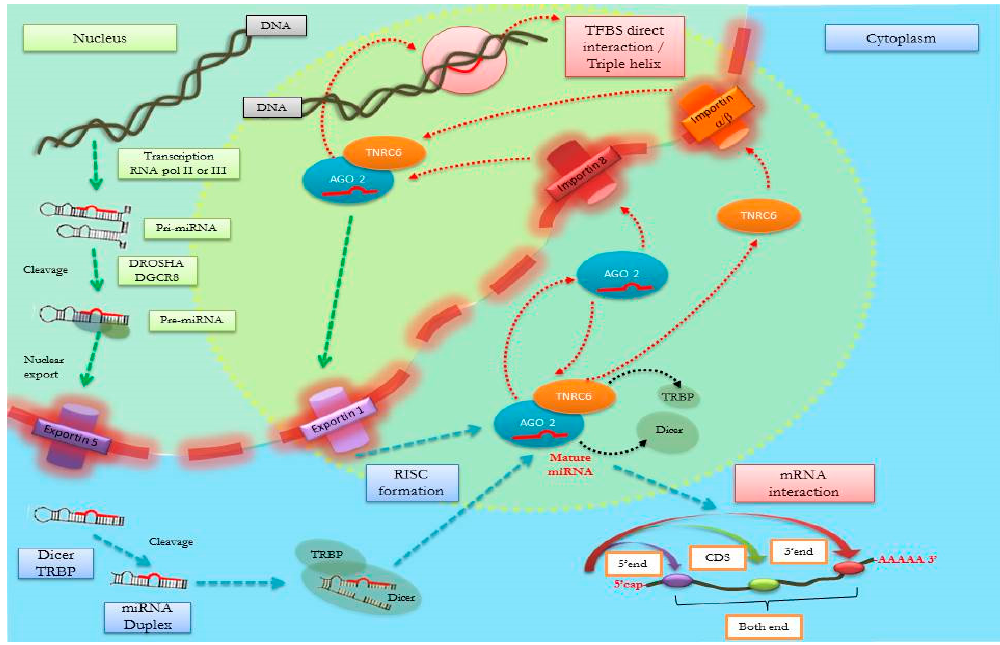
Figure 4. Several steps of microRNA (miRNA) biogenesis and nucleus–cytoplasm transport. Mature miRNAs derive from longer double-stranded primary transcripts (pri-miRNA), which are recognized and processed in the nucleus by the Drosha protein/DGCR8 microprocessor complex subunit (DGCR8) complex into shorter precursors folded in a hairpin loop structure (pre-miRNA). Pre-miRNAs are then exported to the cytoplasm (through Exportin 5) where they are first cleaved by Dicer and later processed by RNA-induced silencing complex (RISC) to form the mature miRNAs. Transactivation response element RNA-binding protein (TRBP) intervenes in the stabilization of Dicer. RISC, which includes Protein argonaute-2 (Ago2), also participates in the identification of miRNAs’ targets. The integrative miRNA network highlights, in the yellow circle, the import of Ago2 with mature miRNA into the nucleus via Importin 8 and trinucleotide repeat-containing gene 6A protein (TNRC6), another component of RISC complex, via Importin β . Nuclear RISC is again assembled to elicit pleiotropic effects by regulating multiple pathways with a direct interaction on DNA transcription factor binding sites (TFBSs) and possible formation of triple-helix structures.